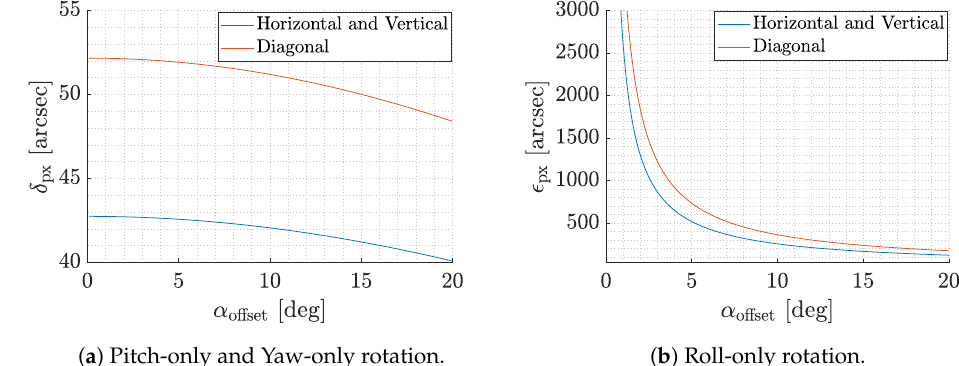
Figure 6. Maximum angular uncertainty for a change in the apparent position of a feature for a displacement in the horizontal, vertical, and diagonal pixel